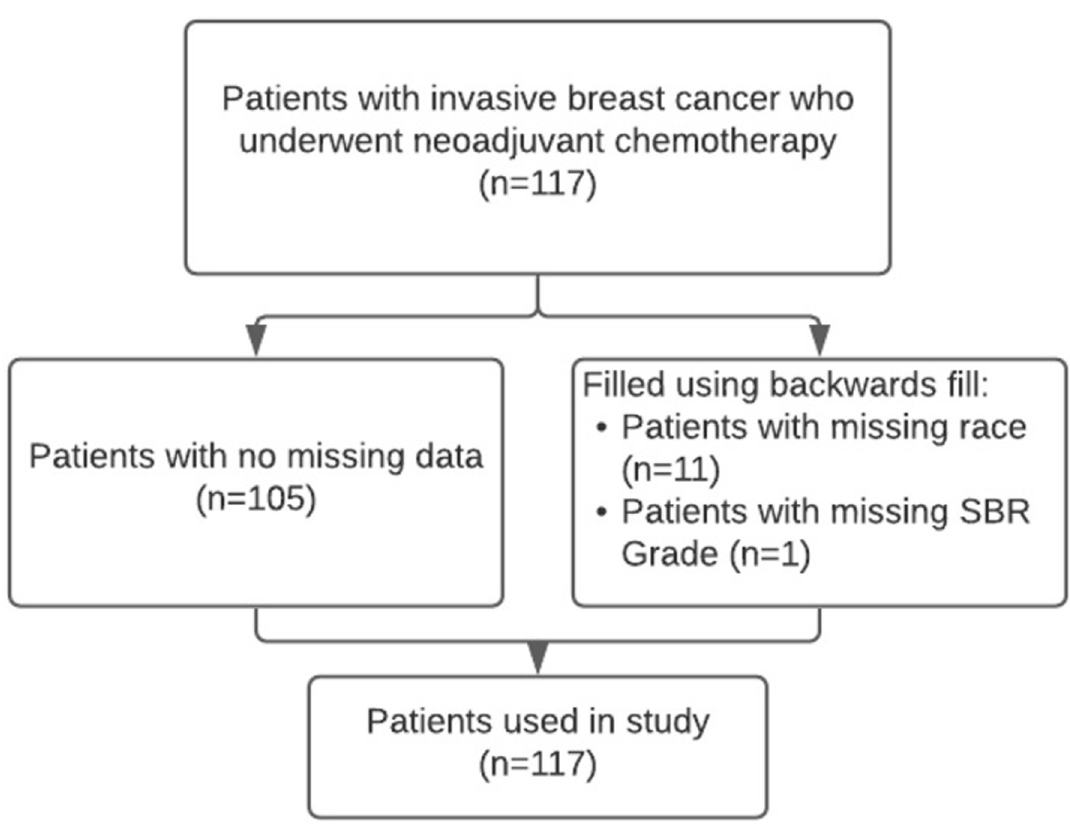
Fig 1. Study population